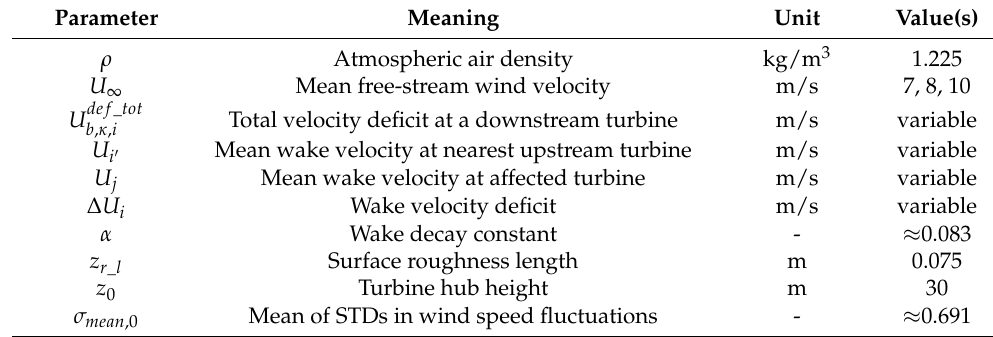
Table 2. A summary of model parameters and assumptions.